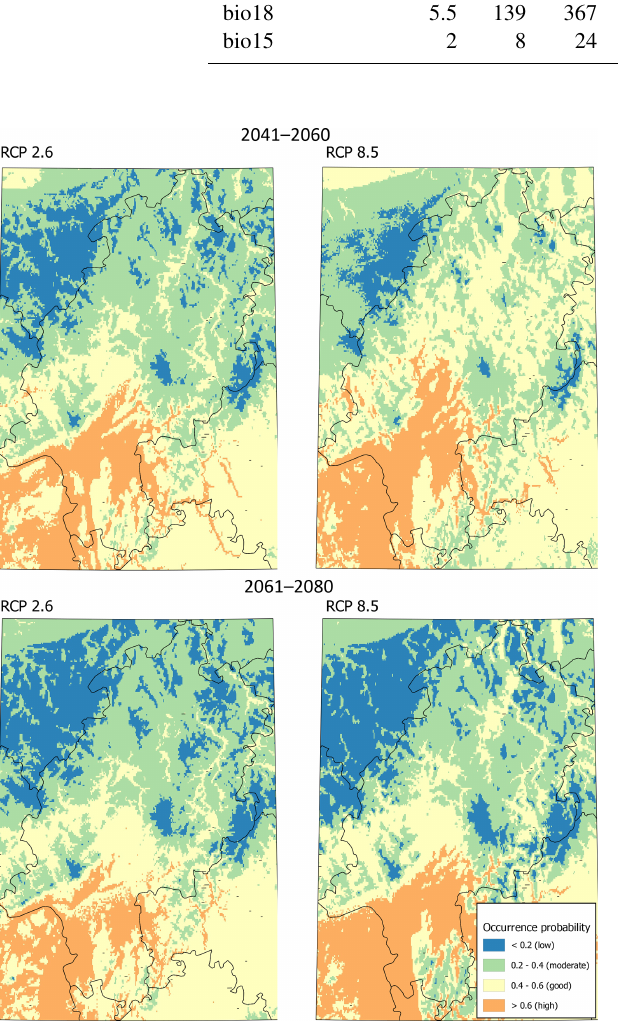
Figure 2. Maps of the potential distribution areas of M. religiosa in Hesse, Germany. The potential future distribution during two time periods was predicted using the identified variables under actual cli- mate conditions and the scenarios RCP 2.6 and RCP